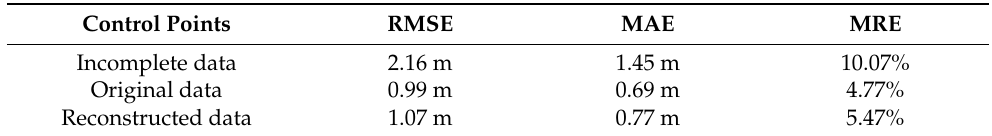
Figure 12. Local study area around the missing data. The red points are the missing data that were manually removed, and the yellow “+” are the in situ water depth points within 50 m around the missing data. Table 7. Accuracy of active–passive fusion water depth inversion under the DBN model in the local study area near the reconstructed data.